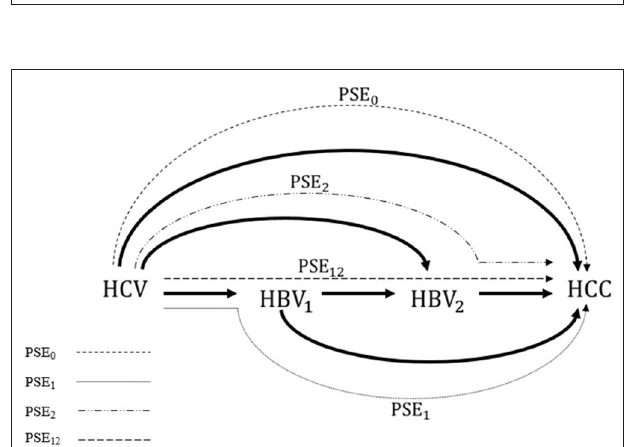
FIGURE 1 | Causal relationship among HCV infection status (HCV), HBV viral load at baseline (HBV 1 ), HBV viral load at follow-up (HBV 2 ), and HCC status (HCC).